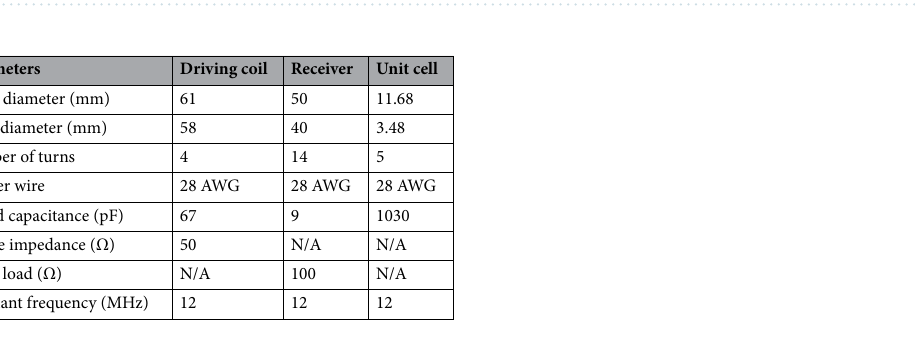
Table 1. Design parameters adopting single strand copper